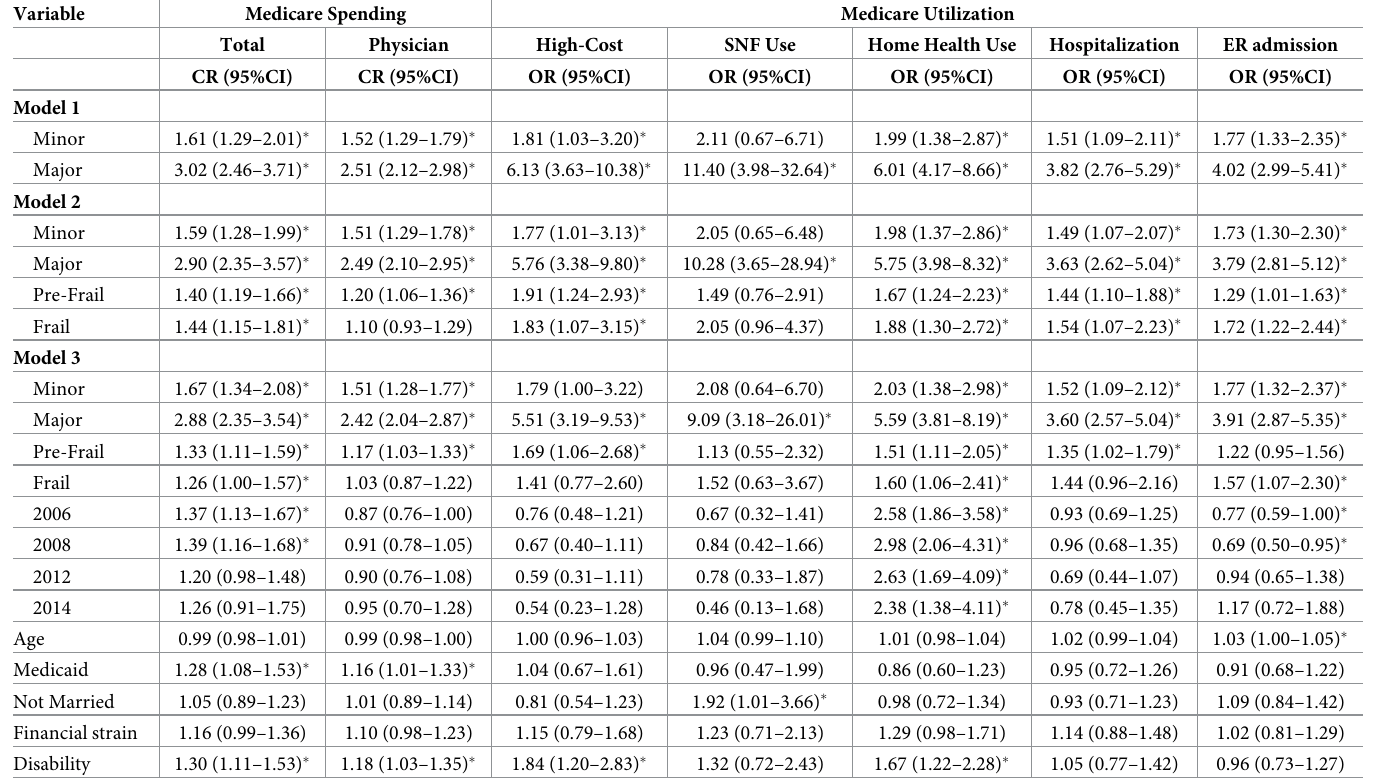
Table 2. Medicare spending and utilization by population